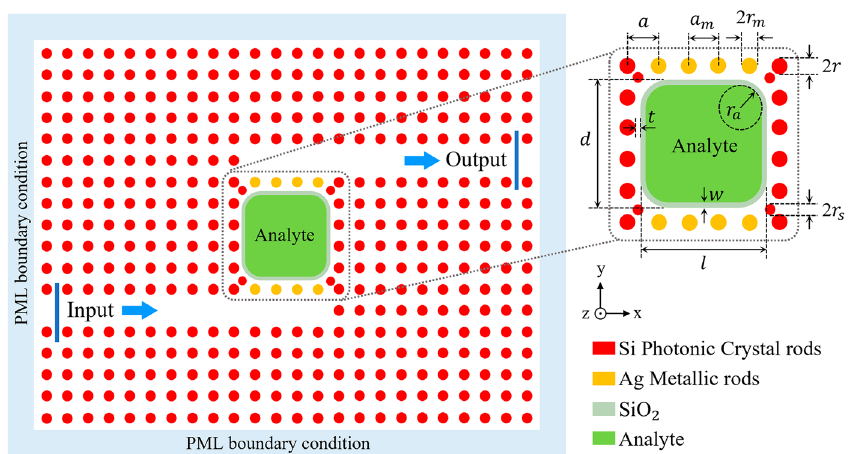
Figure 2. 2D schematic view of the proposed hybrid P-PhC RI sensor structure.